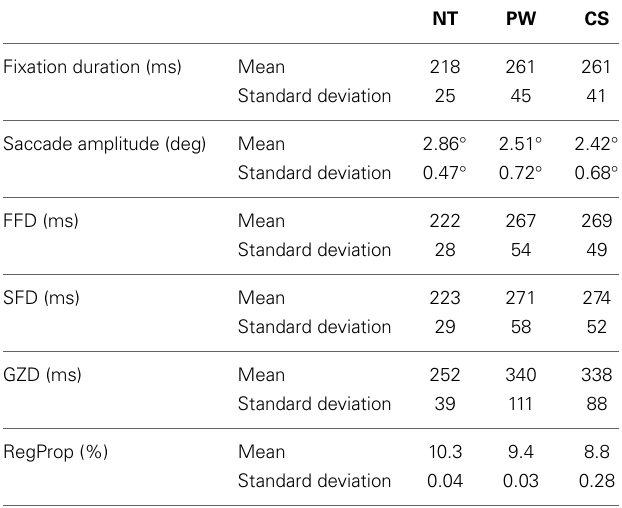
Table 1 | Summary eye movement